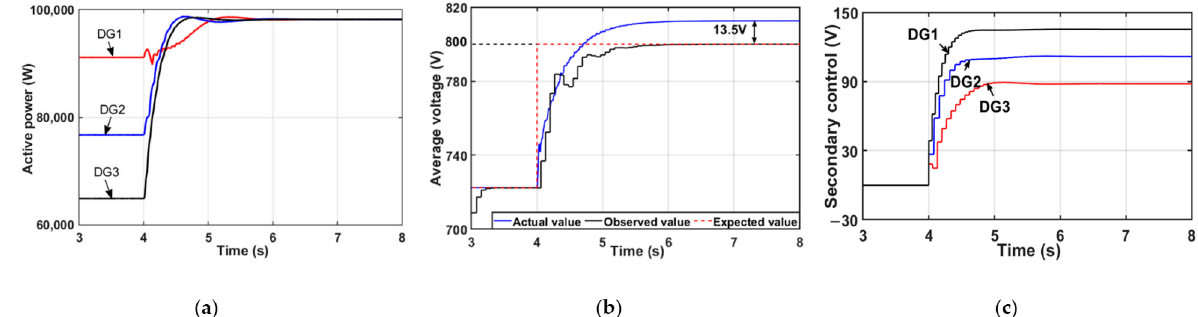
Figure 9. Simulation results for asynchronous sampled system with conventional algorithm. ( a ) Active powers. ( b ) Average voltage. ( c ) Secondary control inputs.